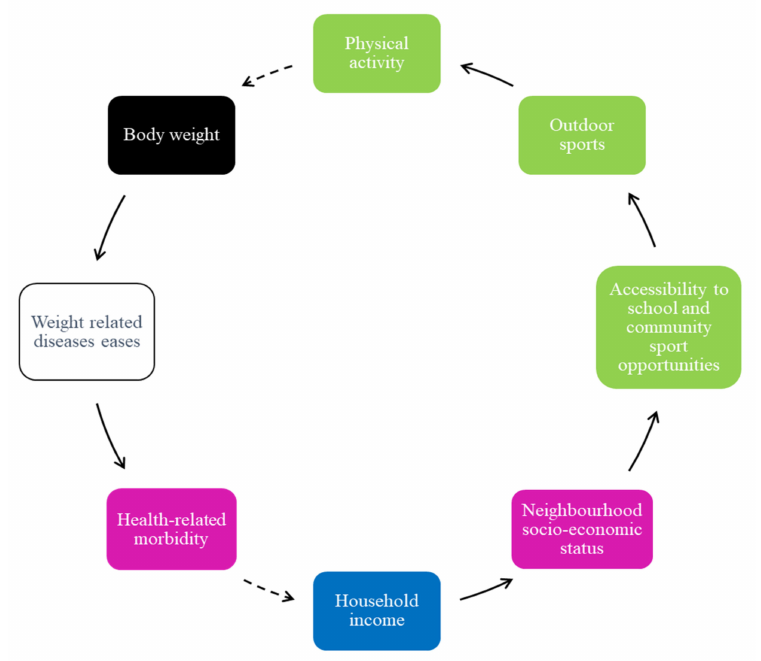
Figure 3. Physical activity, health-related morbidity, and socio-economic